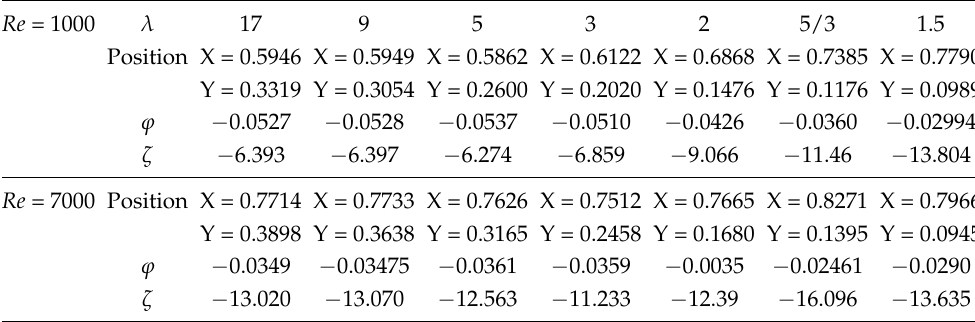
Table 3. Vortex properties of the primary vortex of different geometries at steady Reynolds numbers 1000 and